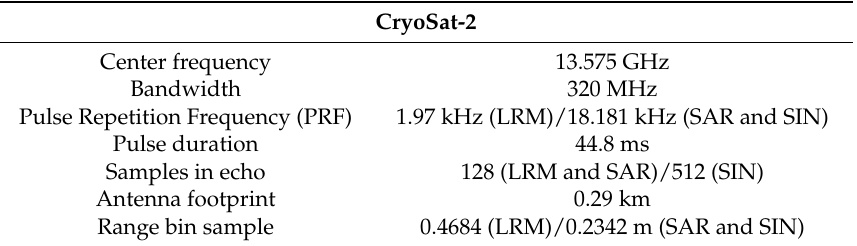
Table 1. The specifications of CryoSat-2 (Synthetic Aperture Interferometric Radar Altimeter (SIRAL). LRM, Low Resolution Mode; SIN, SAR Interferometry.